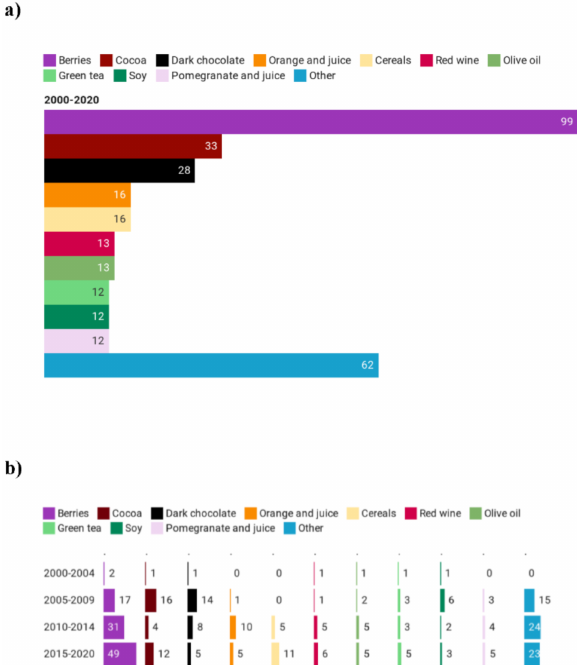
Figure 3. Main polyphenol-rich foods ( a ) used in clinical trials and their trend ( b